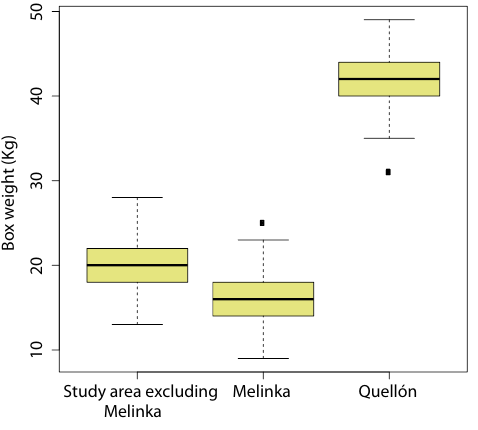
Figure 6. Percentages of UMLS weight difference in the datasets, according to the simulation (Figure